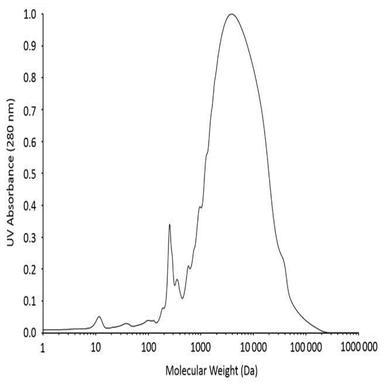
HSQC analysis of the lignin PSS1 isolated after pilot scale soda pulping of Miscanthus x giganteus.